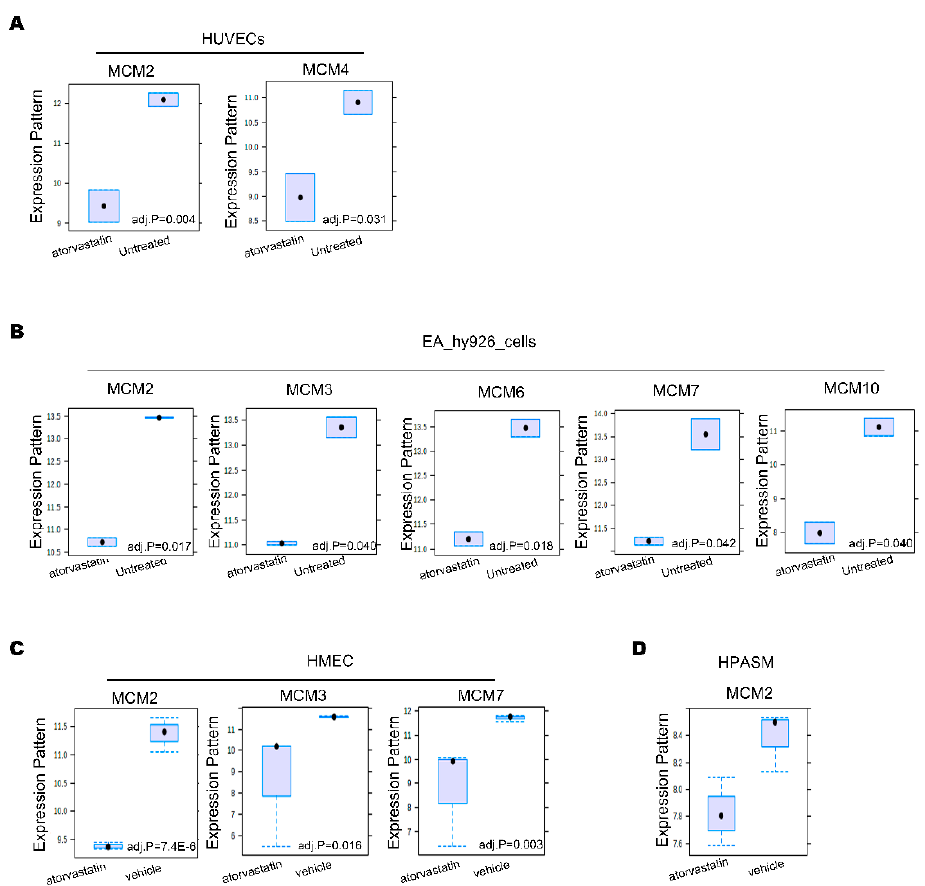
Figure 5. The effect of atorvastatin on MCMs in vascular cells. ( A ). The expression of MCM2 and MCM4 in primary human umbilical vein endothelial cells (HUVECs). ( B ). The expression of MCM2,3,6,7,10 in immortalized HUVEC cell line EA.hy926. ( C ). The expression of MCM2, MCM3 and MCM7 in primary cultures of human microvascular endothelial cells (HMVEC). ( D ). The expression of MCM2 in primary cultures of human pulmonary artery smooth muscle cells (PASMC).